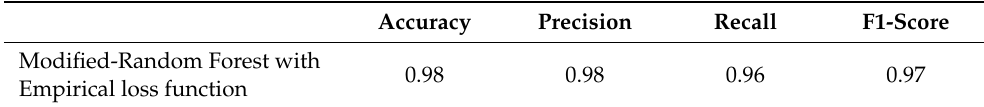
Table 1. Analysis of proposed Modified-Random Forest.